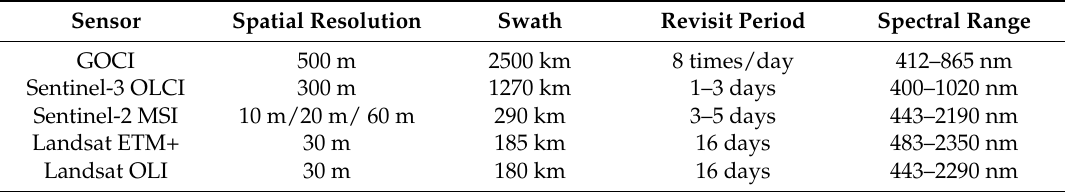
Table 1. Specifications of satellite data used in this study, including data collected with GOCI, Sentinel-3 OLCI, Sentinel-2 MSI and Landsat OLI.